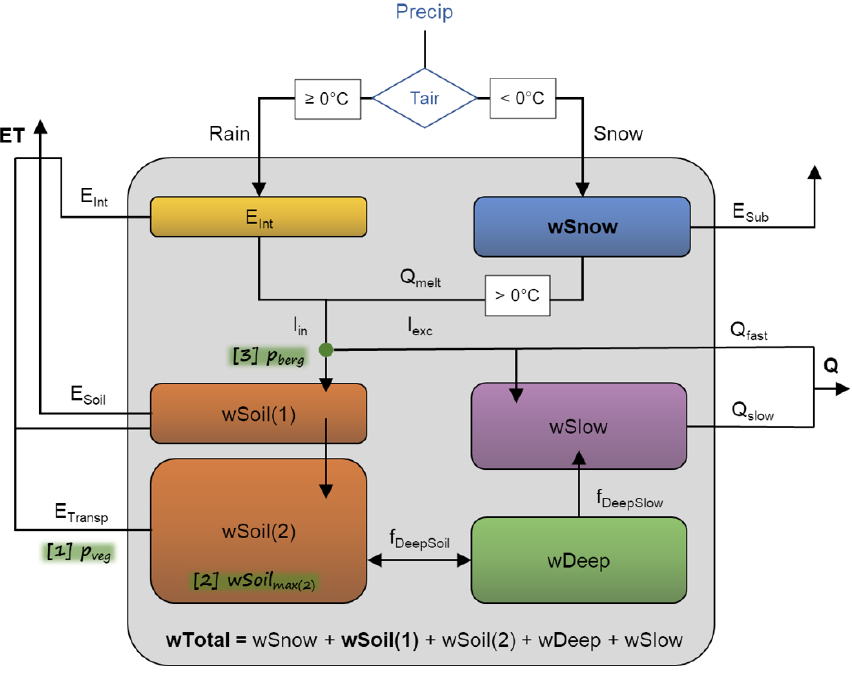
Figure 1. Schematic of the underlying model structure, with blue font denoting forcing data: Precip is precipitation, and T air is air tempera- ture. Boxes represent states as follows: E int is interception storage, wSnow snow water storage, wSoil(1) upper soil layer, wSoil(2) second soil layer, wDeep deep water storage, and wSlow slowly varying water storage. Arrows denote fluxes as follows: Rain is rainfall, Snow snowfall, E Sub sublimation, Q melt snowmelt, I in incoming water from throughfall and snowmelt, I exc infiltration excess, Q fast fast direct runoff, Q slow slow runoff, Q total runoff, E Int evaporation from interception storage, E Soil soil evaporation, E Transp plant transpiration, ET total evapotranspiration, f DeepSoil the flux between wSoil and wDeep (percolation resp. capillary rise), and f DeepSlow the flux from wDeep to wSlow. Bold print highlights model variables that are constrained in the calibration. Green highlights show where vegetation influence is included explicitly: [1] the parameter p veg to define each grid cell’s vegetation fraction, [2] the parameter wSoil max(2) that defines the maximum plant-available soil water, and [3] the parameter p berg to define the infiltration and runoff generation